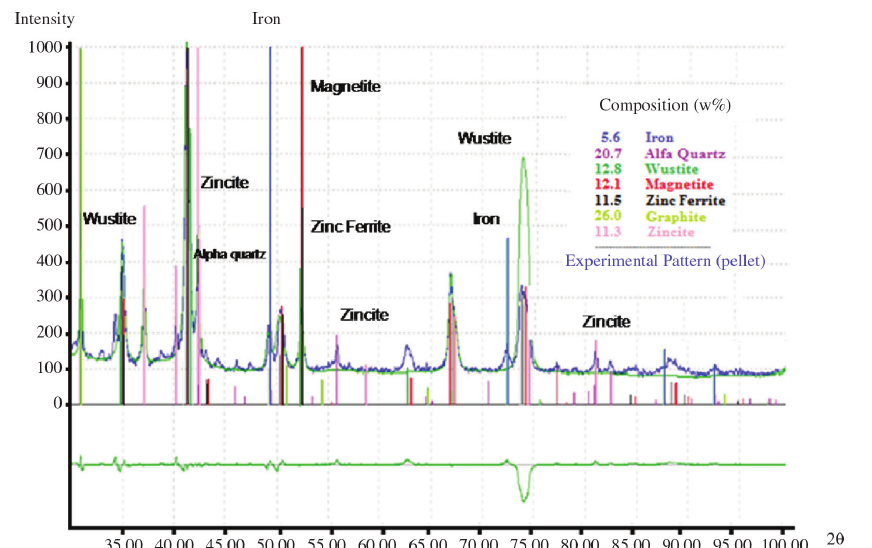
Figure 2. Average spectra for the 4 area of the self-reducing pellet produced with EAF dust. *Quantify of carbon (graphite) is not